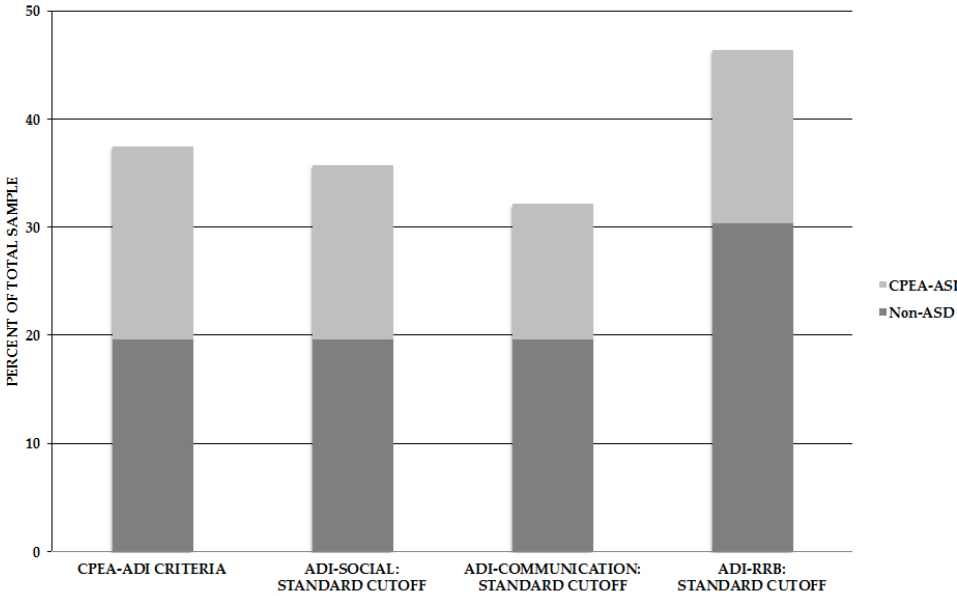
Figure 4. Figure 4 shows the percentages of individuals meeting ADI-R criteria set forth by the CPEA (CPEA-ADI) or standard ADI-R domain cutoff scores. Within each cutoff category, diagnostic groups are designated as those who met CPEA-ASD criteria or those who did not meet these criteria